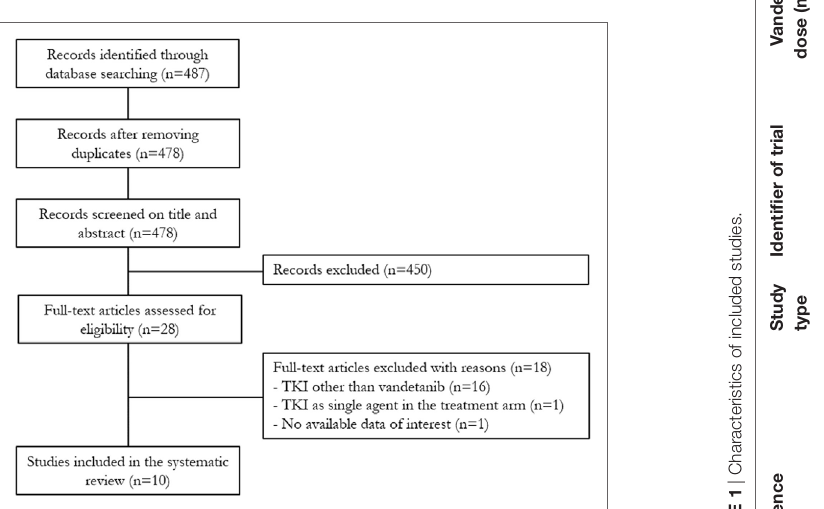
FigURe 1 | Flowchart of the study selection